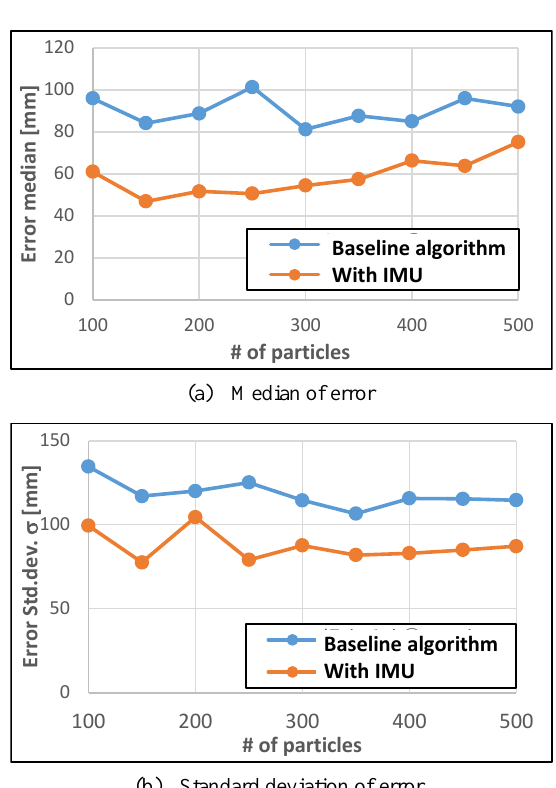
Figure 7. Localization error in different particle settings